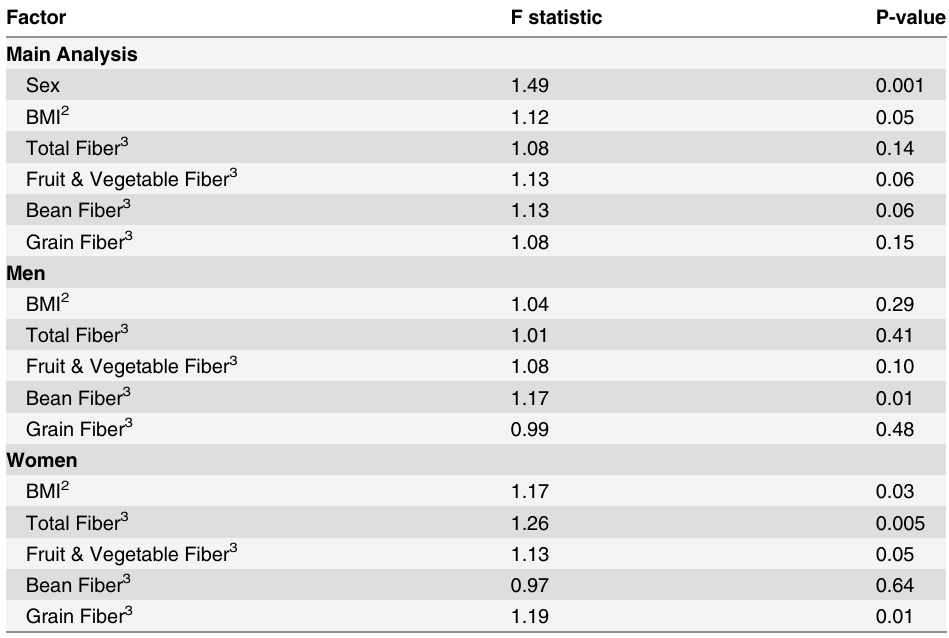
Table 2. PERMANOVA 1 analysis of personal factors with the unweighted UniFrac distance matrix.